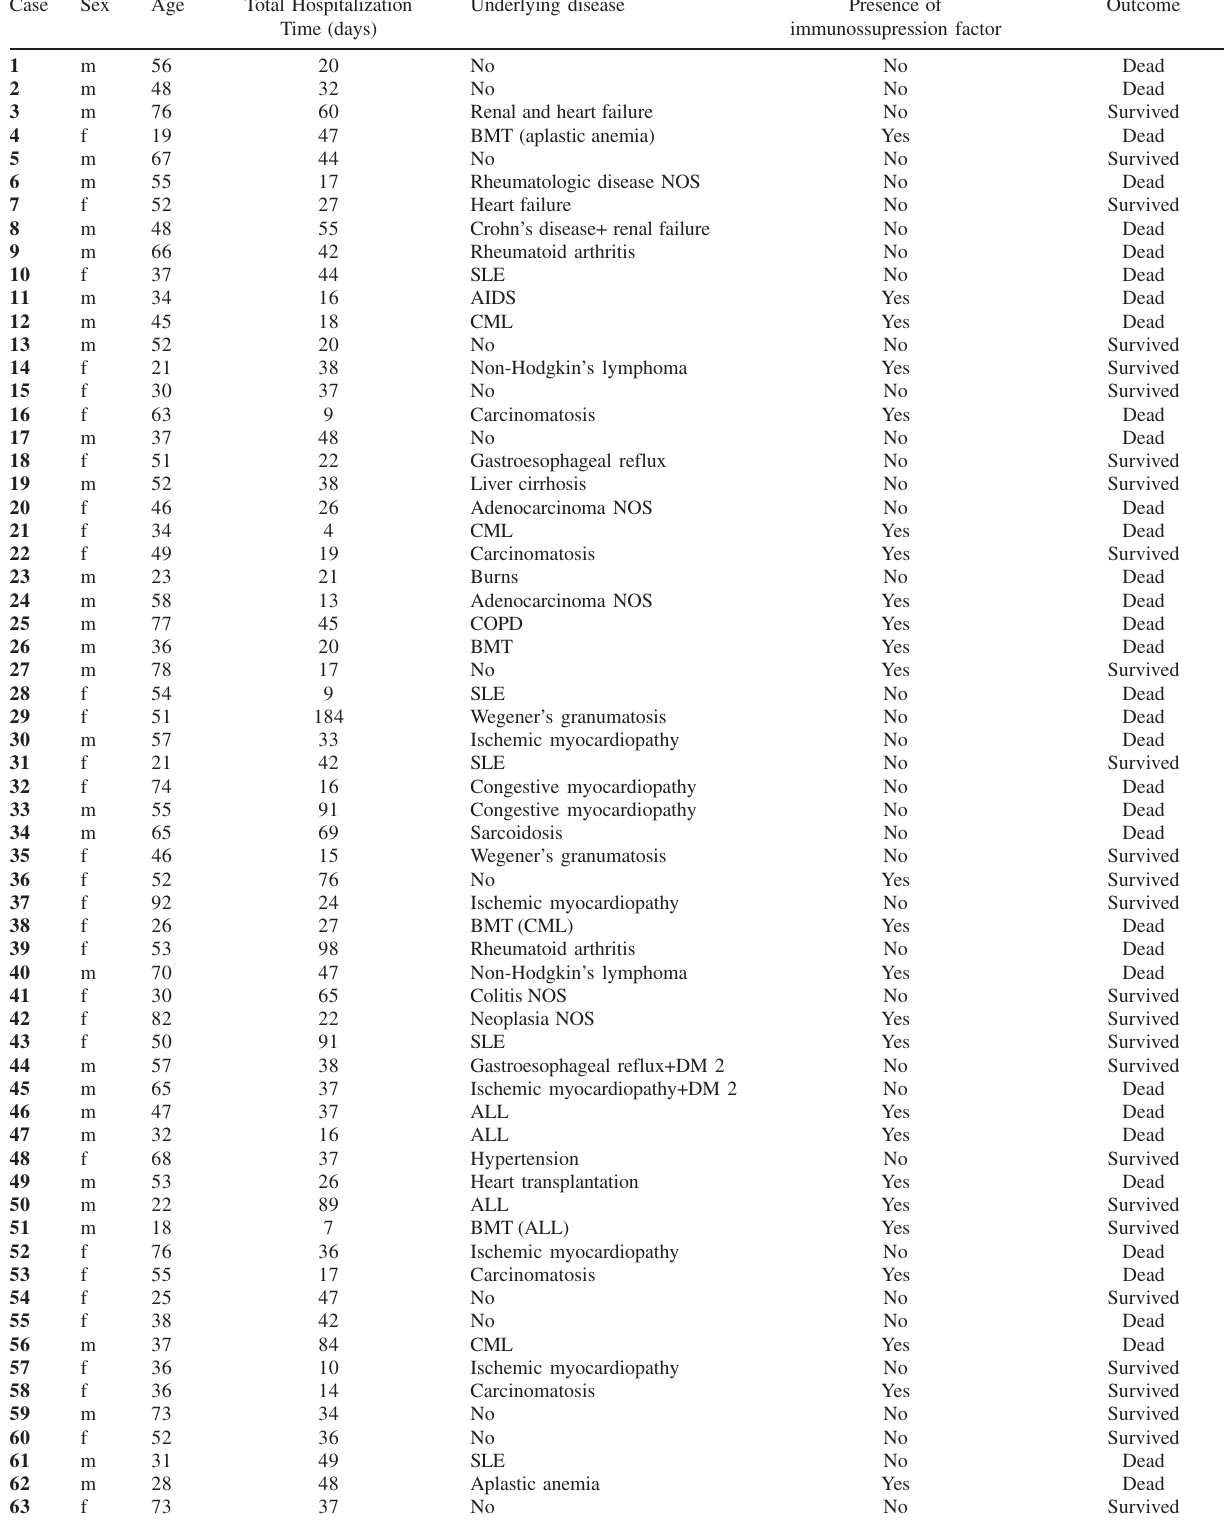
Table 2 - Epidemiological data of the 63 patients